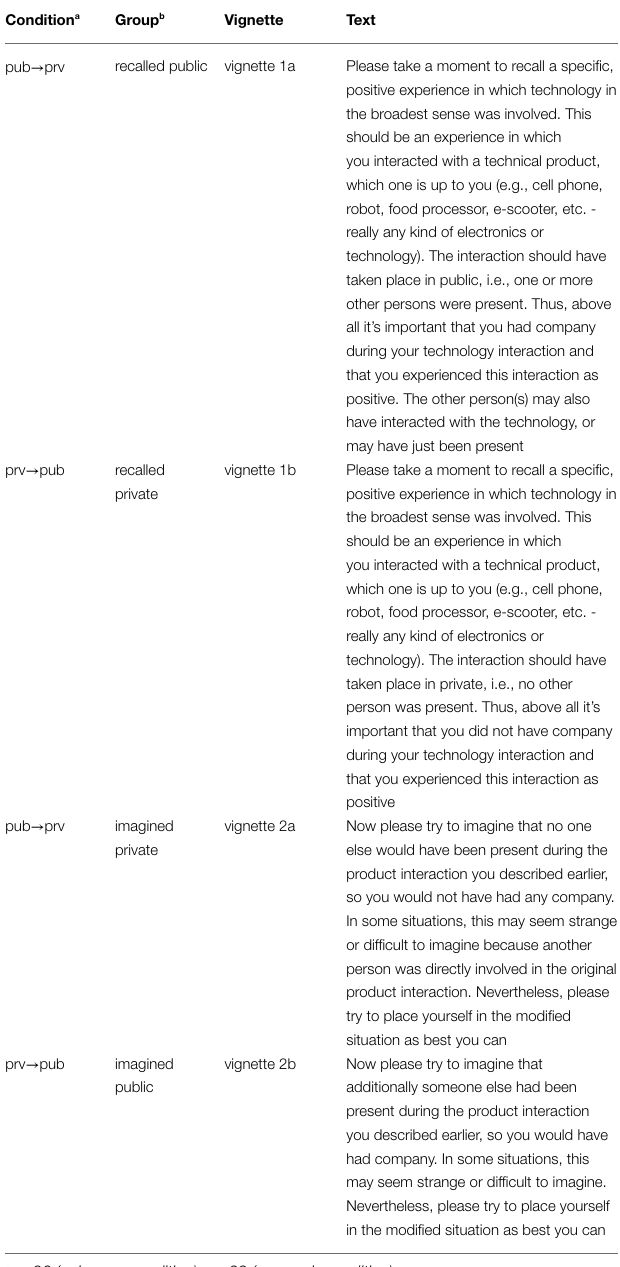
TABLE 1 | Experimental conditions and corresponding instructions to elicit and modify